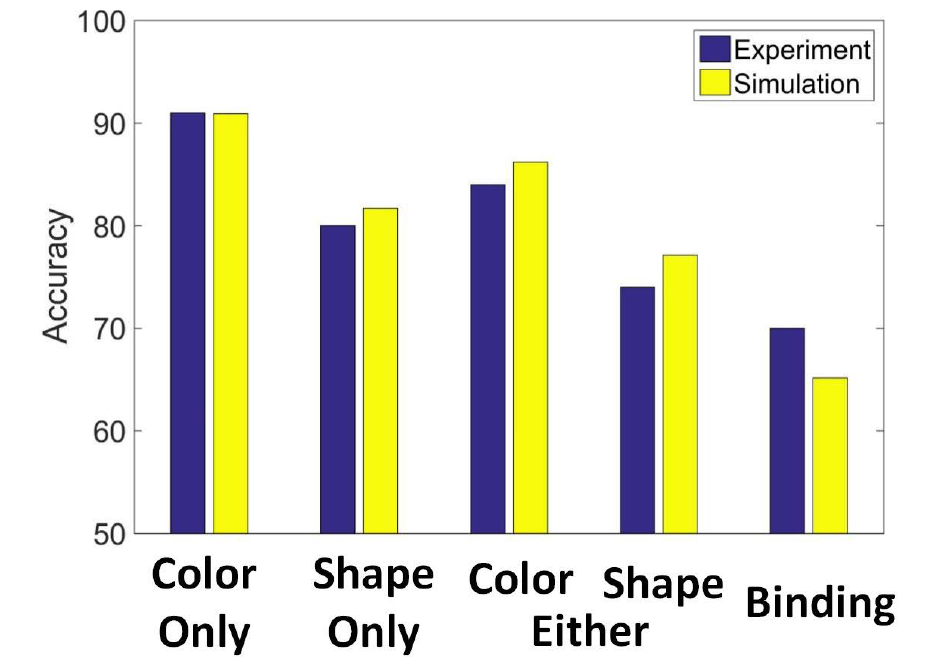
Figure 18. The results of Wheeler and Treisman’s experiment and our model’s simulation